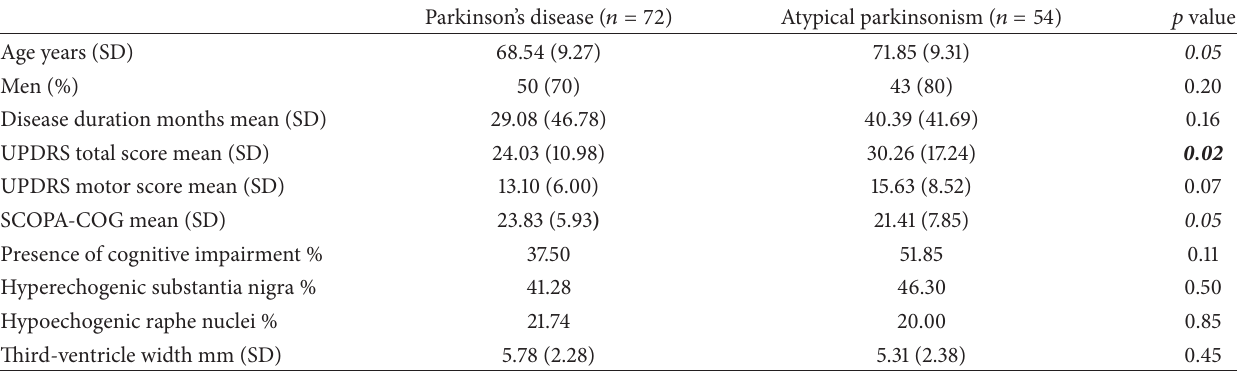
Table 1: Patient characteristics, divided into group of diagnosis.